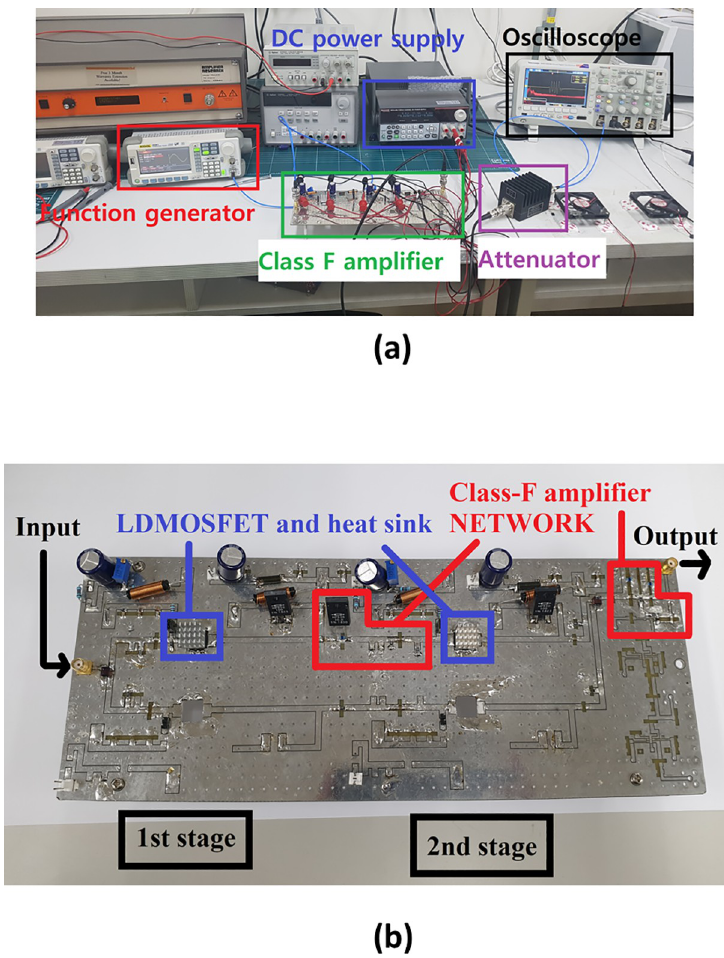
Fig 10. (a) Measurement environment for manufactured class F amplifier performance and (b) zoomed-in manufactured class F amplifier.